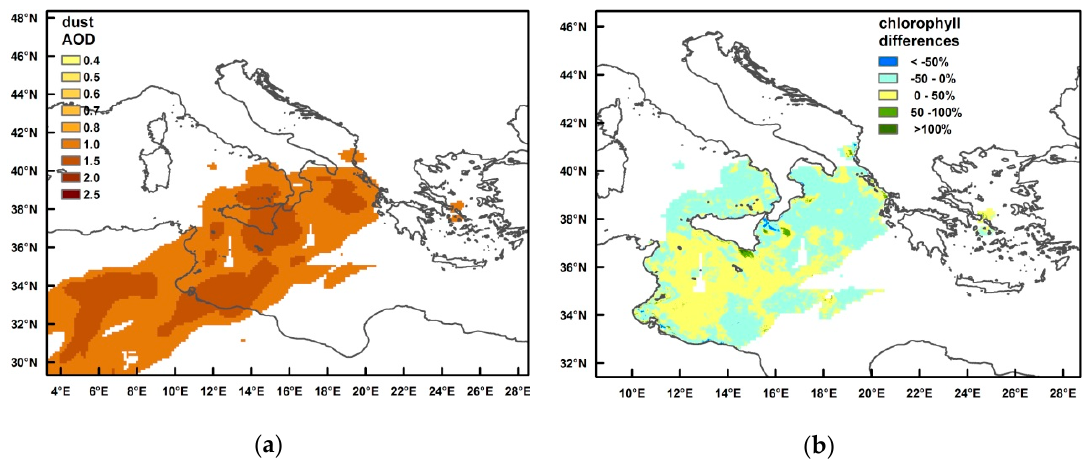
Figure 7. ( a ) Maximum dust AOD >0.8 during the episode 11–13 May 2017 that defined the study area; ( b ) Chl-a % differences between the weeks before (1–8 May 2017) and after (17–24 May 2017) the event.